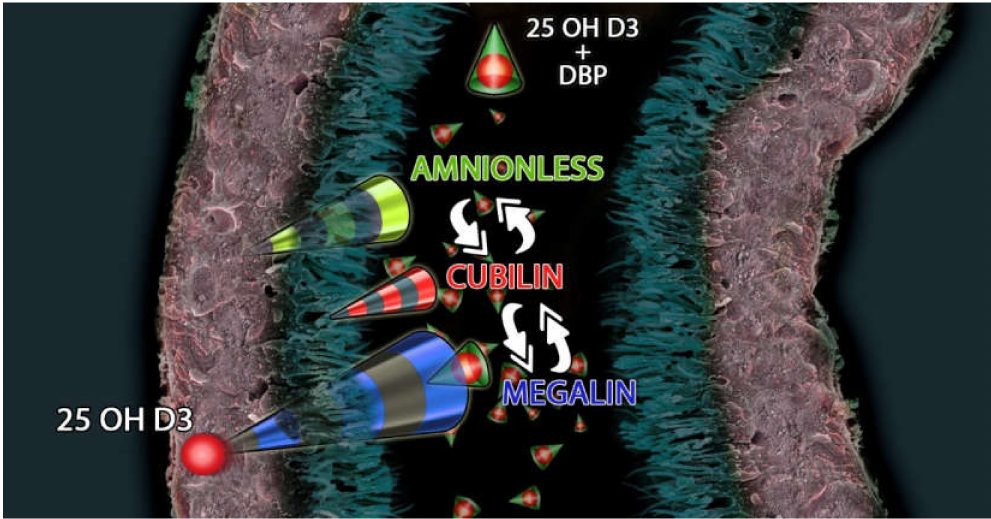
Figure 1. Megalin-Cubilin-Amnionless interacts with 25(OH)D3 and DBP (Vitamin D Binding Protein) complex to modulate the uptake of 25(OH)D3 in the proximal